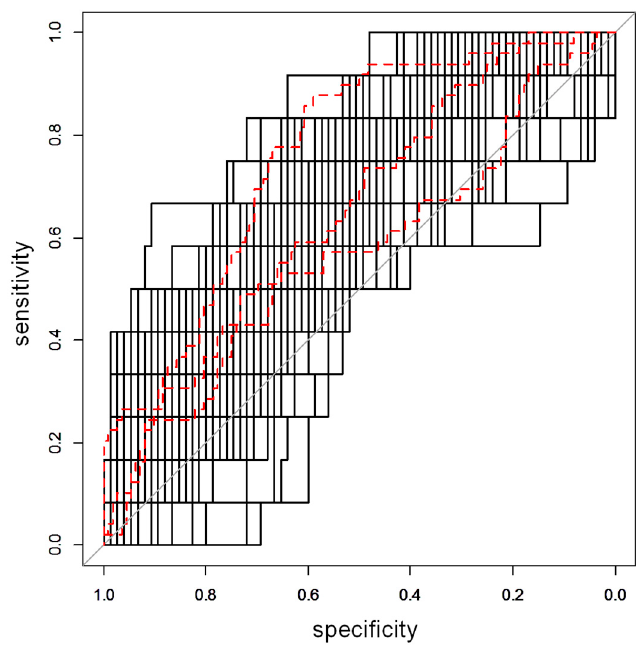
Figure 1. ROC curve for the COPSAC2010 dataset. In the plot, the 100 ROC curves calculated during the projection to latent structures discriminant analysis based on variable influence on projection selection (VIP-based PLS-DA) stability selection procedure for the COPSAC2010 dataset are reported, represented by the black lines. Red, dashed lines indicate the 10th, 50th, and 90th percentiles.